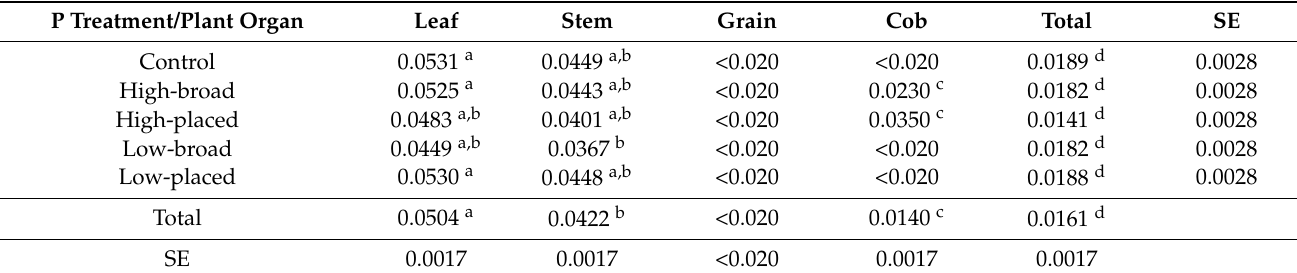
Table 3. Means of Cd concentration (mg kg − 1 DW) and standard error (SE) at the ripening stage as a function of P treatment and maize organs ( n = 160). Different letters indicate significant differences at the p < 0.05 level (Tukey’s test). P Treatment/Plant Organ Leaf